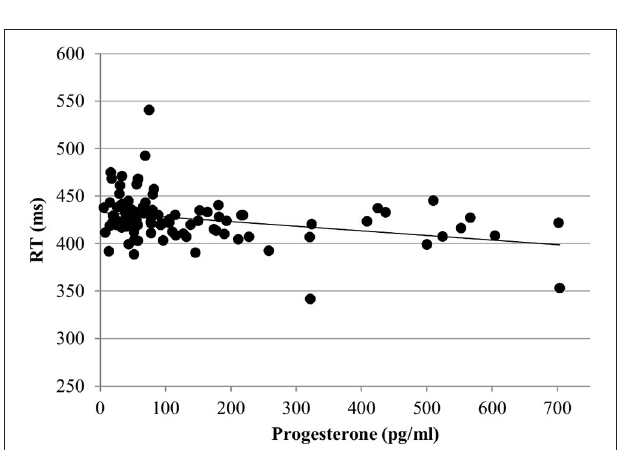
FIGURE 4 | Relationship of progesterone levels to reaction time (RT) for the targets of the N-back task. Responses to targets were slower the lower the progesterone levels of